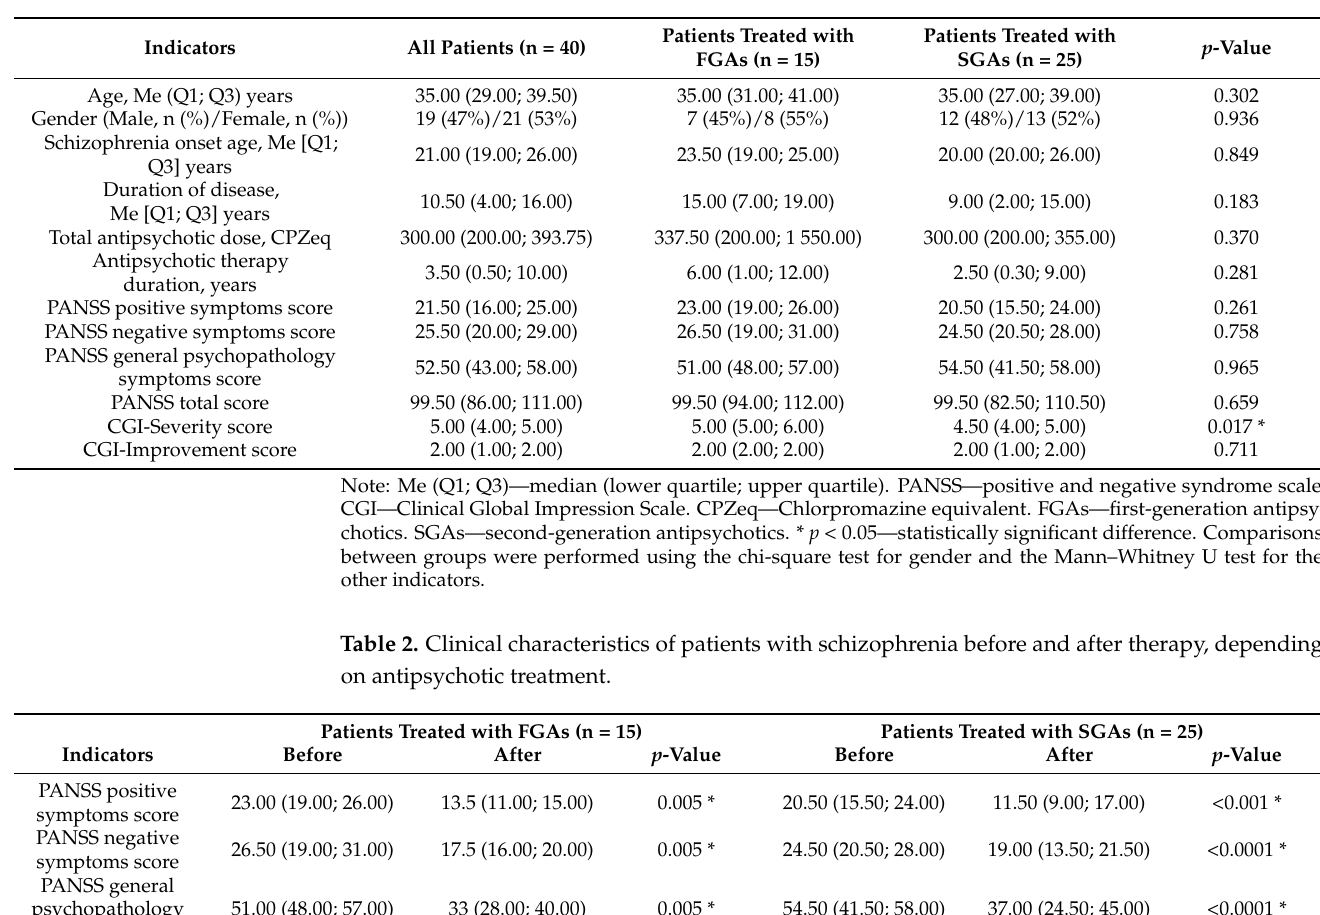
Table 1. Sociodemographic, clinical, and pharmacological characteristics of patients with schizophre- nia, depending on antipsychotic treatment.